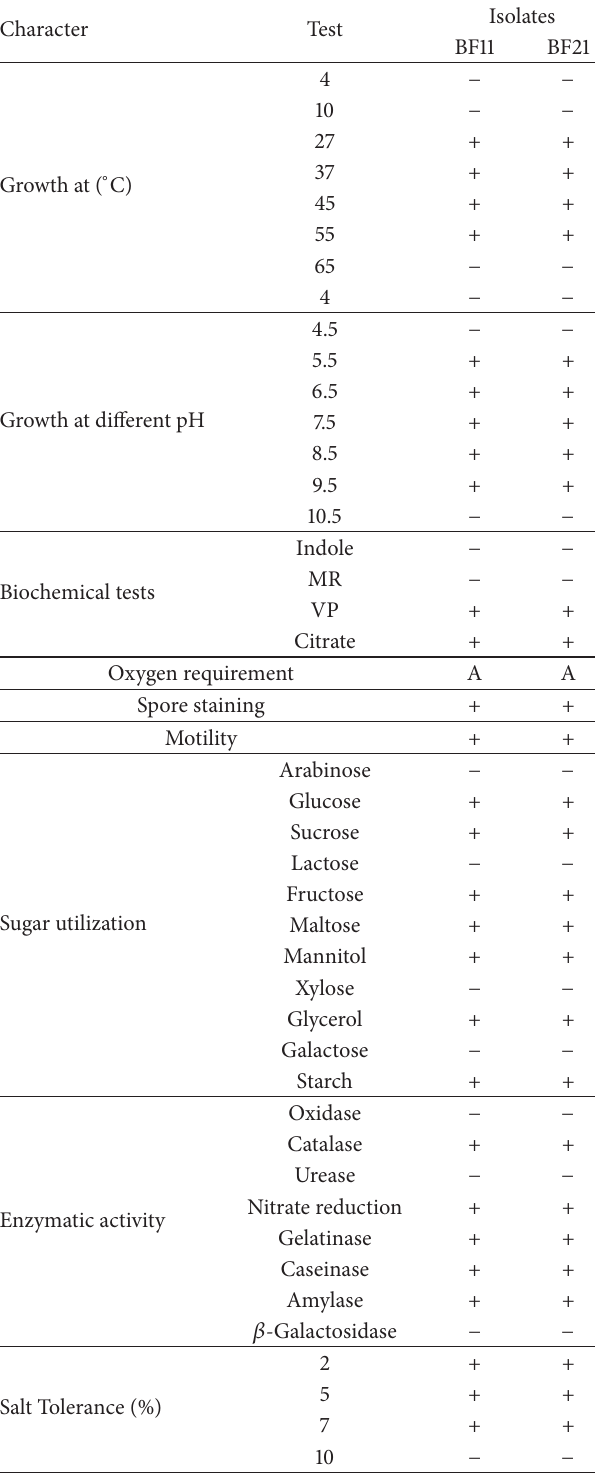
Table 1: Morphological and biochemical characterization of BF